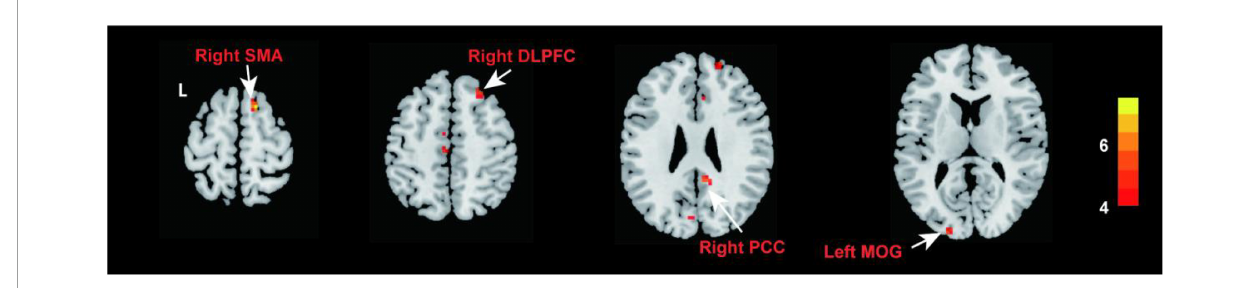
FIGURE2 Comparison of fALFF between patients with PED and NCs ( P < 0.05, FDR correction). Warm color represents an increase. fALFF, fractional amplitude of low frequency fluctuation; FDR, false discovery rate; PED, psychogenic erectile dysfunction; NCs, normal controls; PCC, posterior cingulate cortex; DLPFC, dorsolateral prefrontal cortex; MOG, middle occipital gyrus; SMA, supplementary motor area.